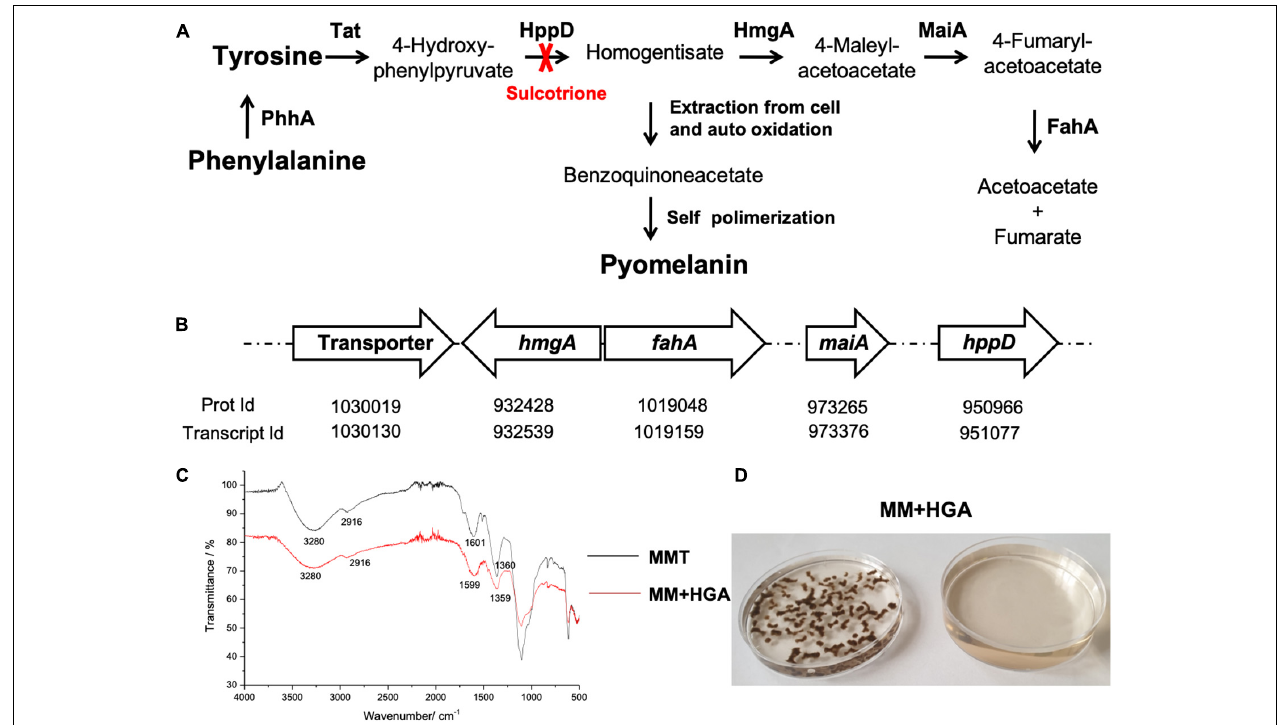
FIGURE 1 | Pyomelanin synthesis in A. alternata by L-Tyrosine degradation to HGA. (A) L-Tyrosine degradation pathway and pyomelanin synthetic pathway. The enzymes indicated in bold as follows: PhhA, phenylalanine hydroxylase; Tat, L-tyrosine aminotransferase; HppD, 4-hydroxyphenylpyruvate dioxygenase; HmgA, homogentisate dioxygenase; MaiA, maleylacetoacetate isomerase; FahA, fumarylacetoacetate hydrolase. (B) Arrangement of the genes putatively involved in these pathways in A. alternata . The pyomelanin pigment derives from L-tyrosine through formation of 4-hydroxyphenylpyruvate and HGA which conversion is inhibited by sulcotrione. HGA is catabolized into acetoacetate and fumarate and depending on the HmgA activity, HGA may accumulates and can be secreted from the cell (Yabuuchi and Ohyama, 1972). Then, after auto-oxidation into benzoquinoneacetate and self-polymerization, forms a brown pigment, pyomelanin (Rodríguez et al., 2000). The genes encoding the enzymes involved in these pathways were found in A. alternata SRC1lrK2f v1.0 genome, at JGI: http://genome.jgi.doe.gov (The Genome Portal of the Department of Energy Joint Genome Institute). The transporter (Prot Id 985975) may be involved in the transport of HGA out of the cell. (C) FTIR spectra of the pigments obtained from culture medium of A. alternata grown in MMT (black) and in MM + HGA (red). (D) Culture medium and mycelia of A. alternata grown in MM + 5.5 mM